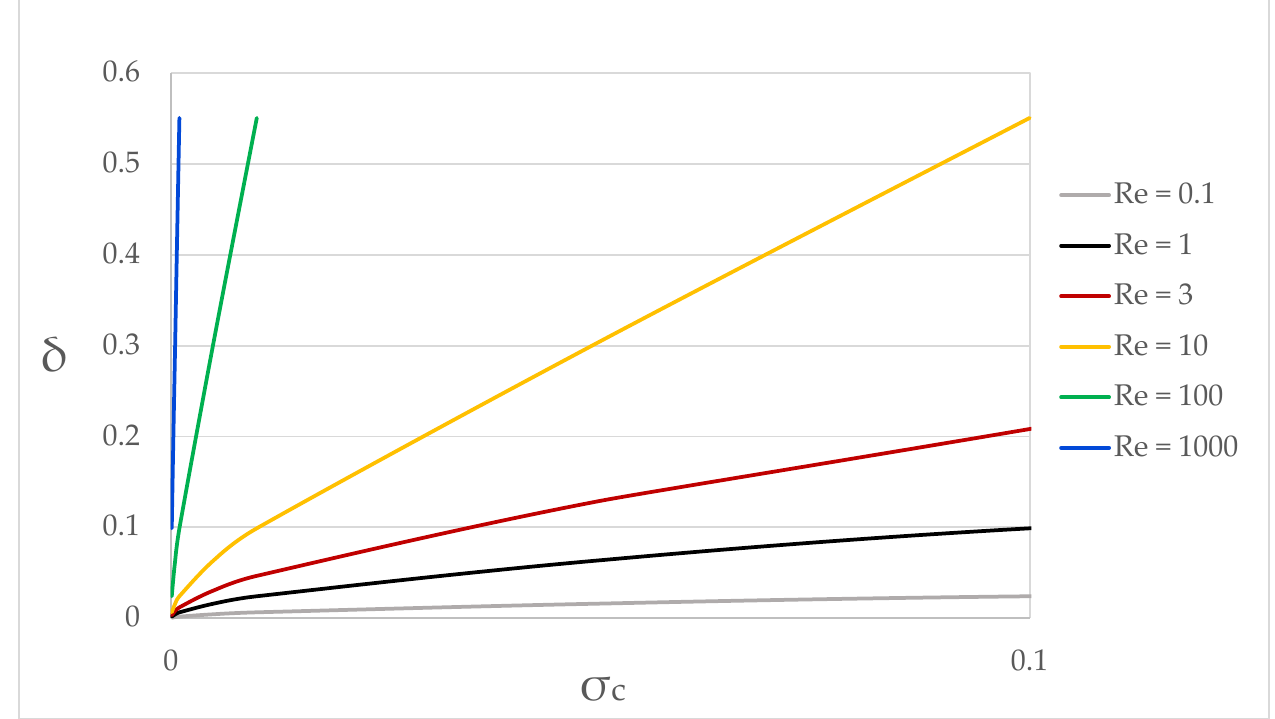
Figure 3. The slenderness parameter vs. the cavitation number for different Reynolds numbers.